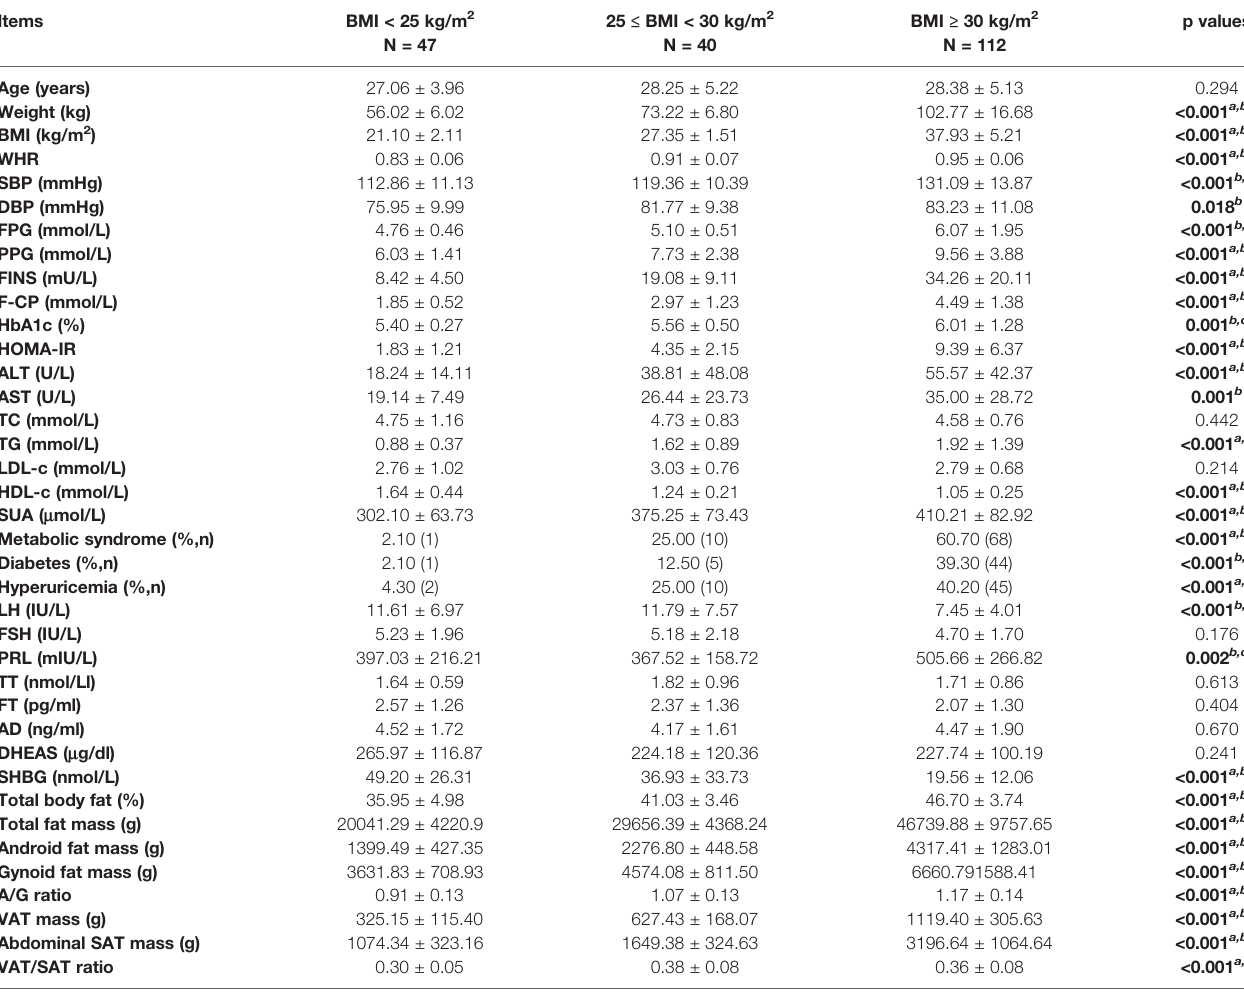
TABLE 1 | Anthropometric, metabolic, and hormonal characteristics and body fat distribution of the patients with PCOS strati fi ed by BMI. Items BMI < 25 kg/m 2